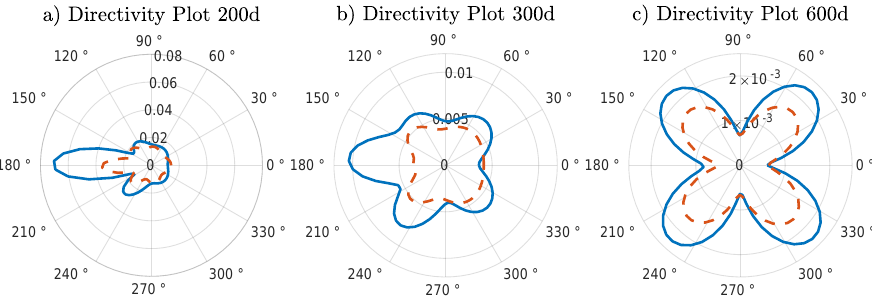
Figure 15. Directivity plot of the p rms [Pa] determined by the nonlinear solution of the FW-H equation on points placed on concentric circles at ( a ) r = 200 d , ( b ) r = 300 d and ( c ) r = 600 d ; the solid line is the rigid case and the dashed line is the FSI